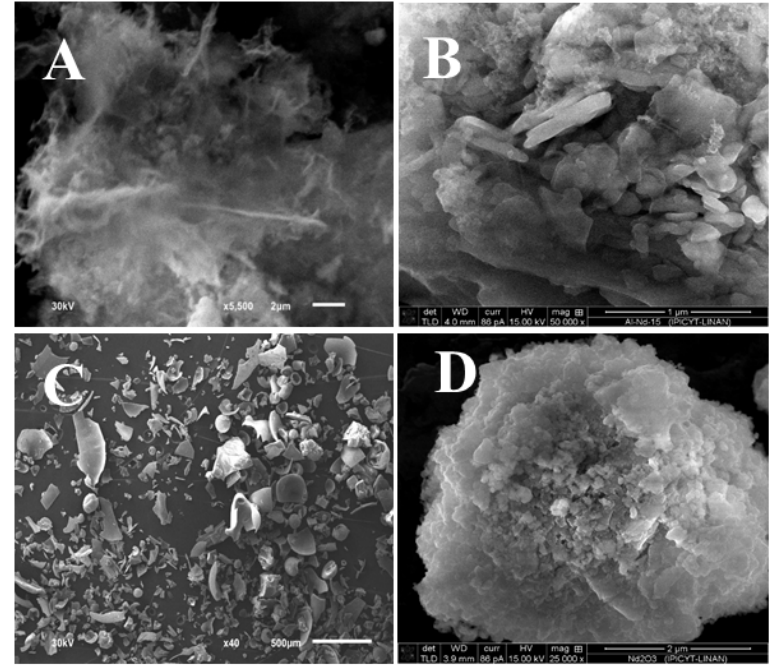
Figure 5. SEM micrographs of ( A ) γ -Al 2 O 3 ; ( B ) Al-Nd-15; ( C ) Al-Nd-25; ( D ) Nd 2 O 3 .